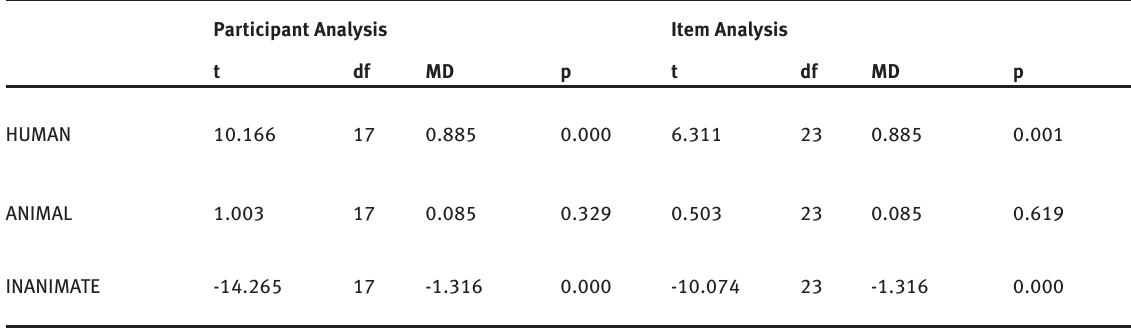
Table 2. Pairwise comparisons of overt and zero occurrence of DOM for each main animacy level.